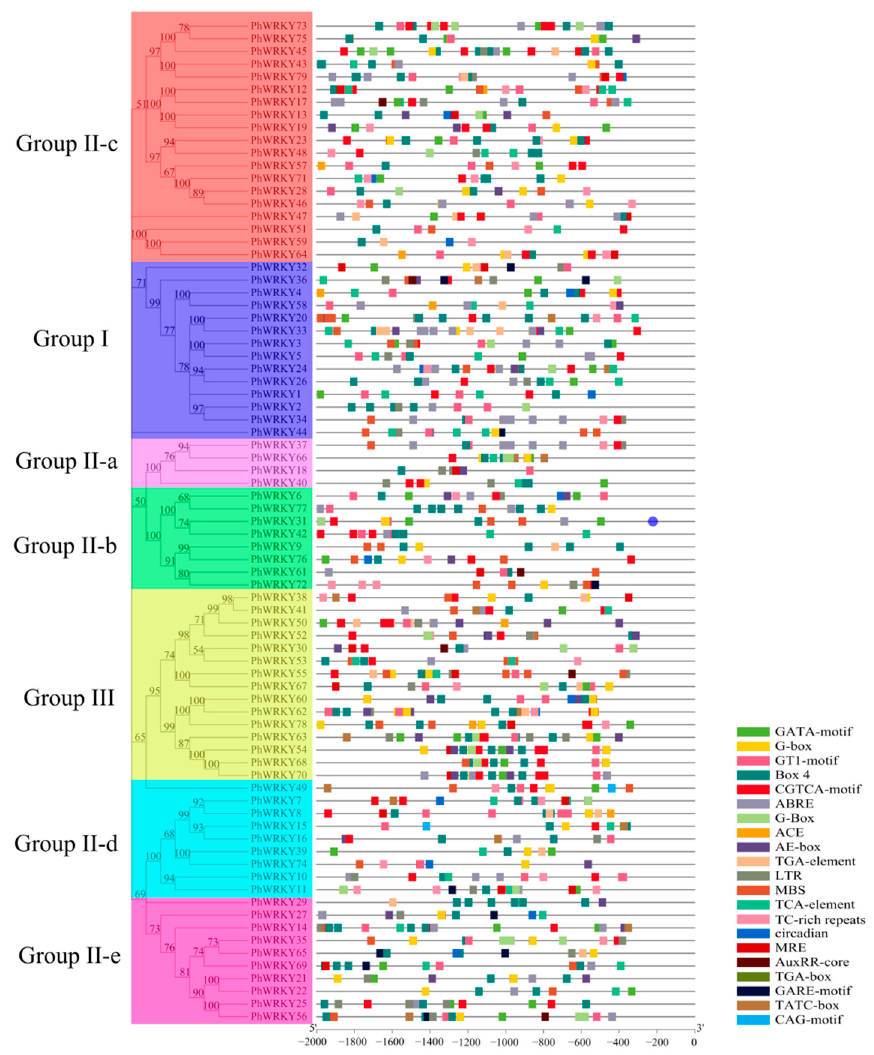
Figure 3. Types of cis-acting elements in promoter regions of PhWRKY genes.